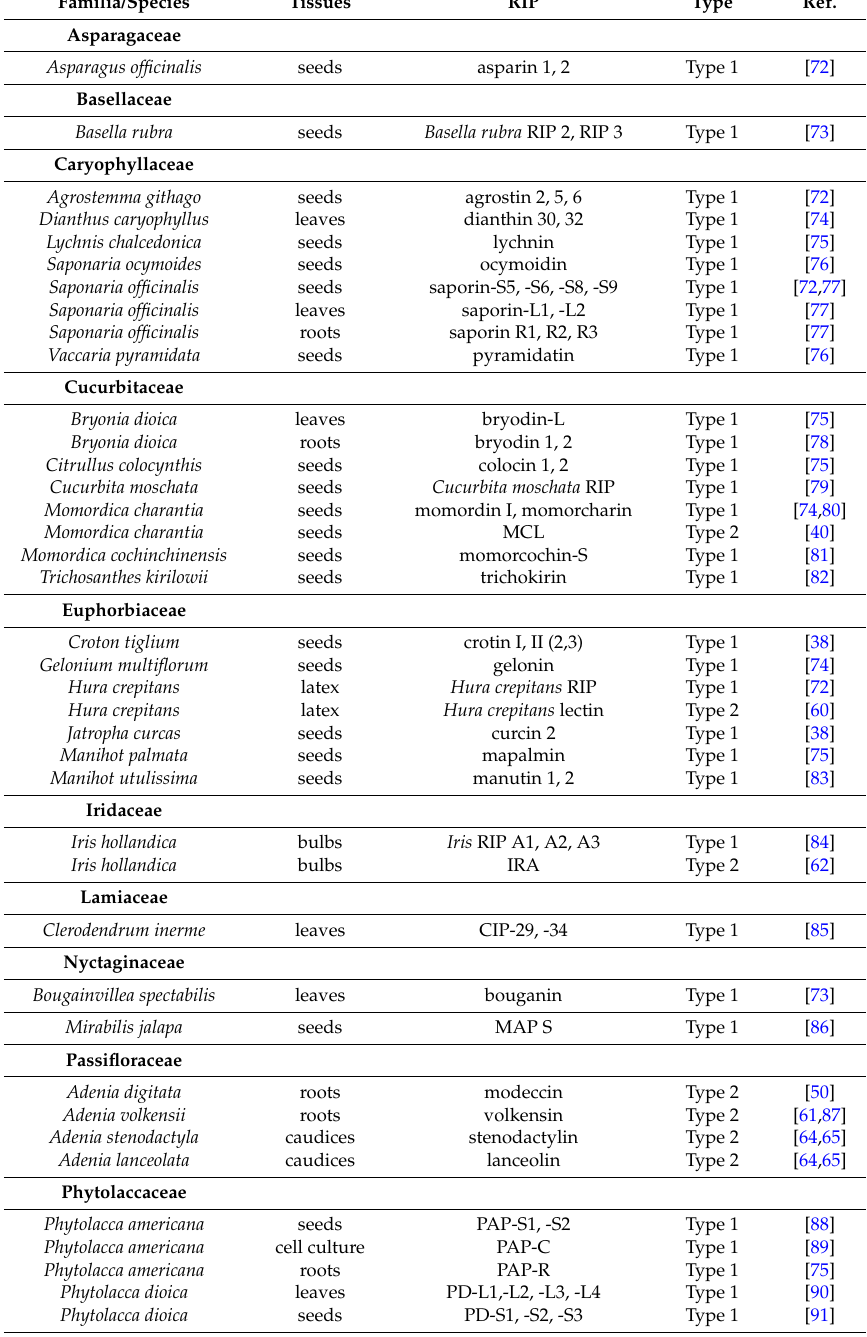
Table 1. RIPs isolated and characterized by Stirpe and